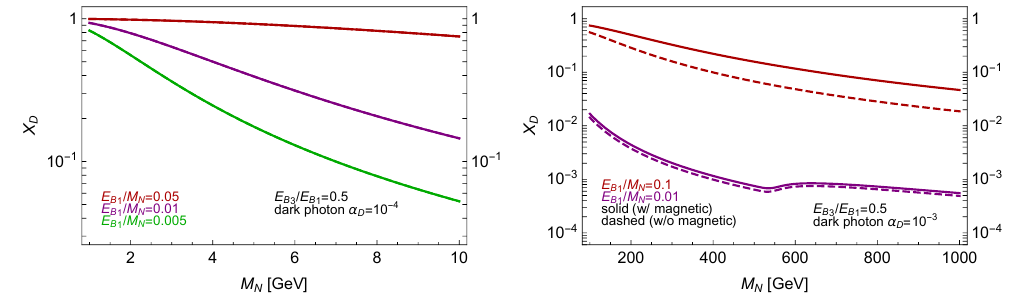
Figure 4 . Dark deuterium abundance in models with 2 degenerate (cid:13)avours and a dark photon. SU(2) doublet, Q . The dark deuterium is an s -wave bound state in the singlet or a triplet F rep of SU(2) with spin 1 or 0 F